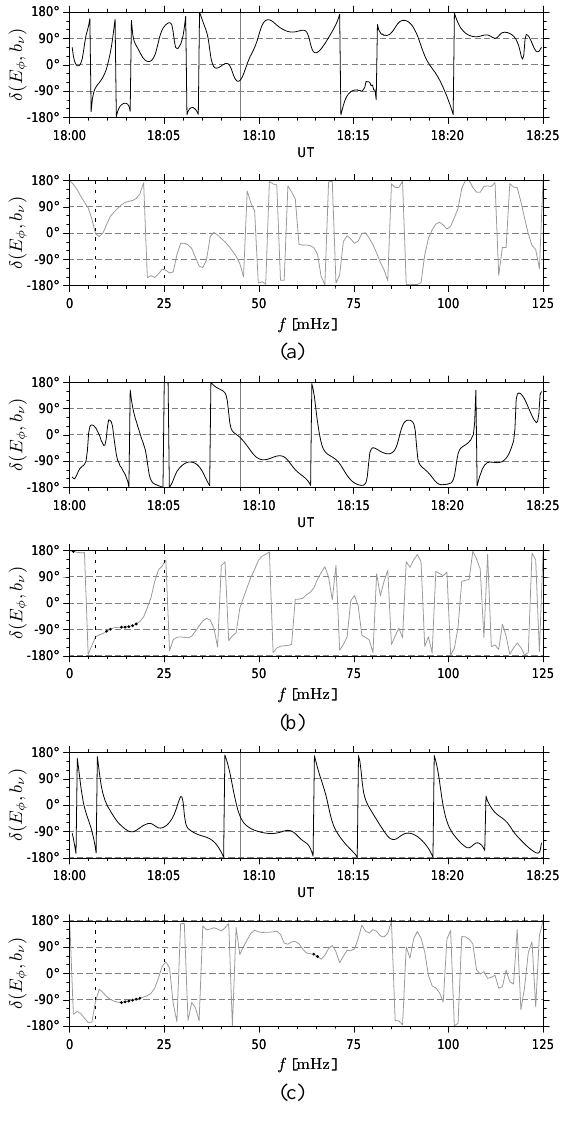
Fig. 9: Phase difference between E ν and b φ at (a) C1, (b) Fig. 9. Phase difference between E ν and b φ at (a) C1, (b) C2 and C2 and (c) C4. Solid points are only plotted at frequencies (c) C4. Solid points are only plotted at frequencies for which γ for which γ exceeds the threshold of 75%. exceeds the threshold of